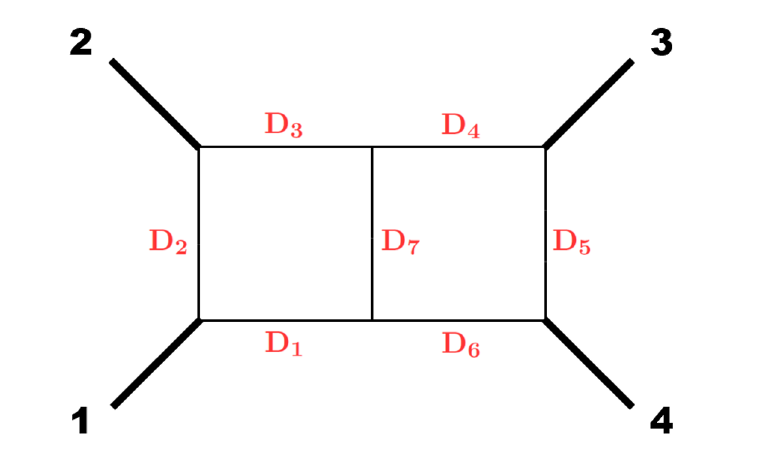
Figure 2. 2-loop diagram with 4 external massive